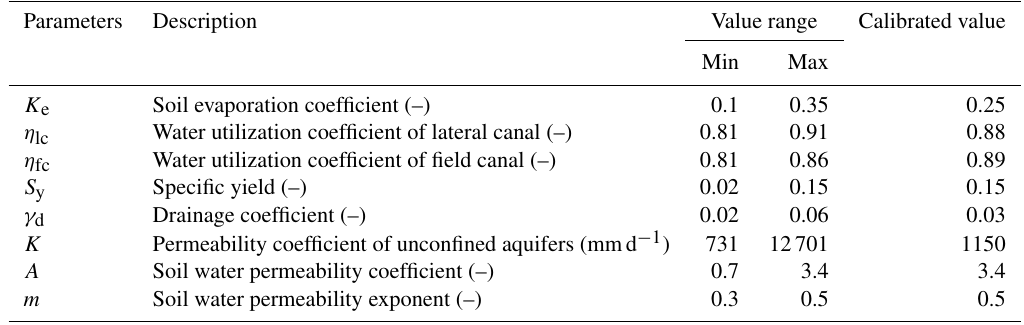
Table 3. The possible parameter variation ranges and calibrated values of the parameters that were collected to describe the soil hydraulic characteristics ( K e , S y , K ) and the irrigation and drainage system ( η lc , η fc , γ d , A , m